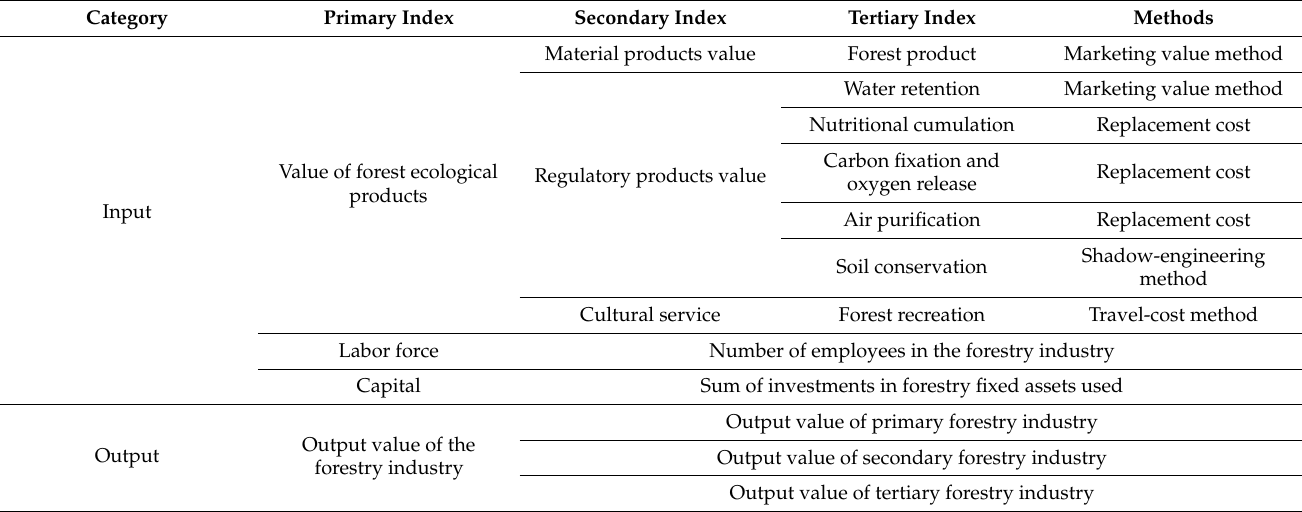
Table 1. Conversion efficiency index system and method of forest ecological products’ value in Zhejiang